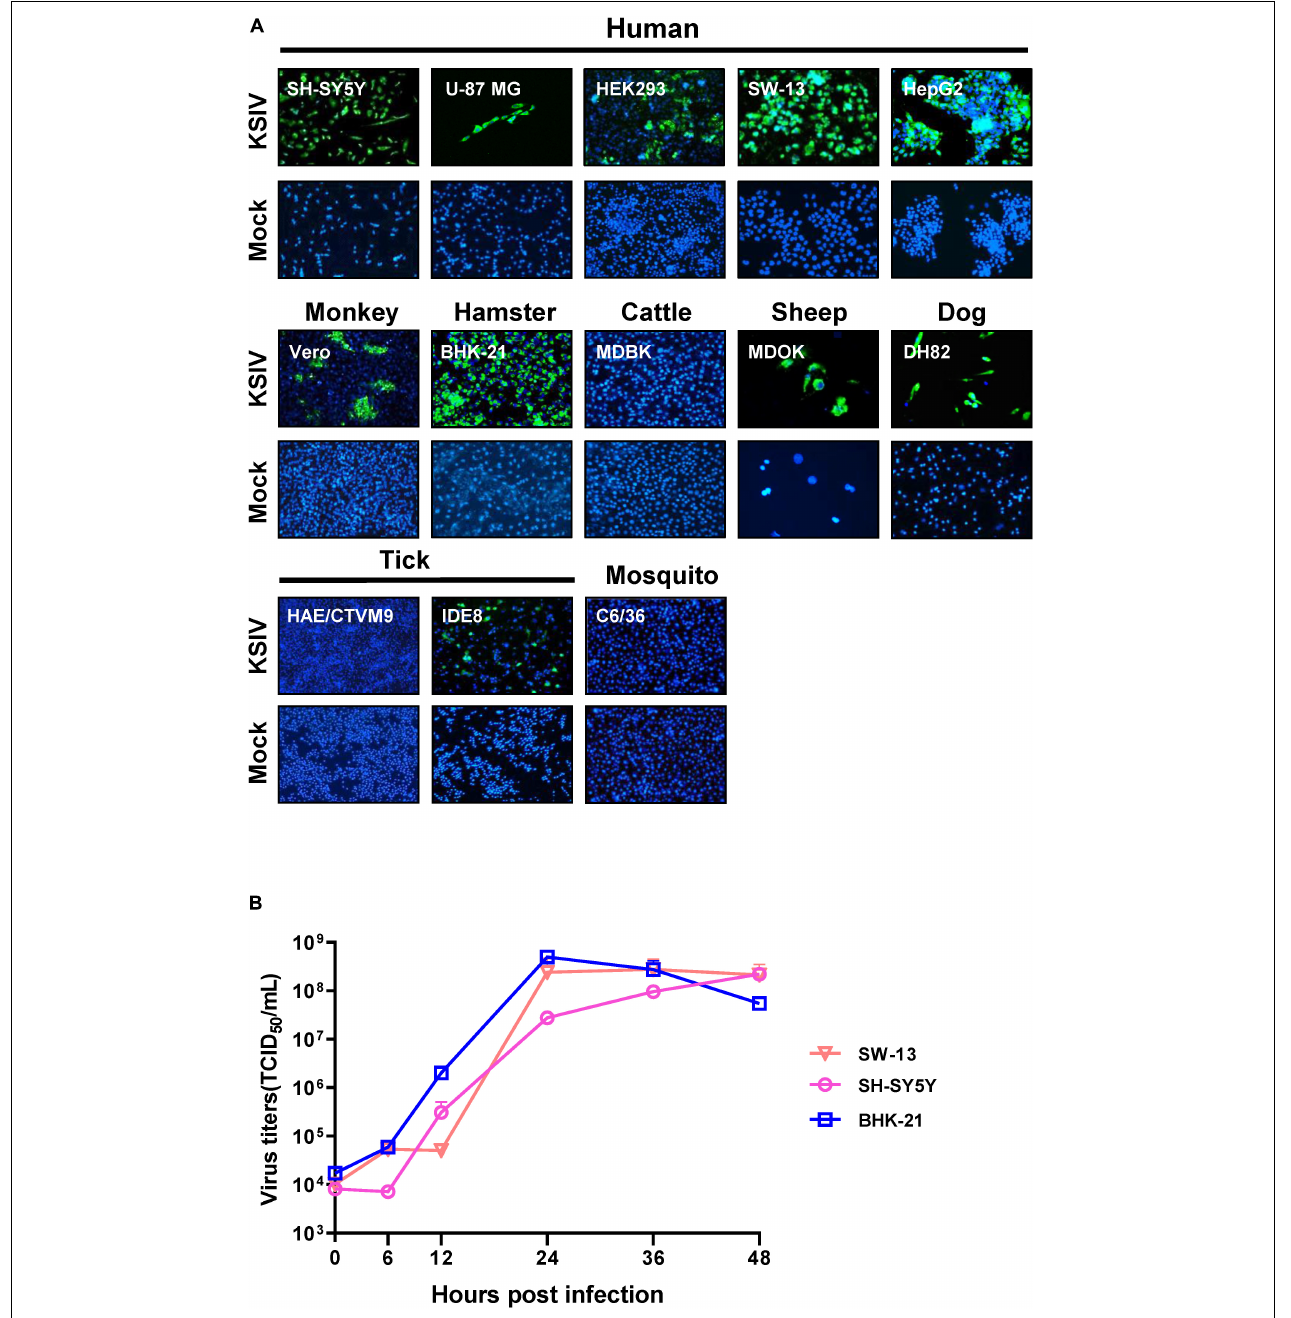
FIGURE 2 | The susceptibility of cell lines derived from different hosts to KSIV and viral one-step growth curve test. (A) Cell lines derived from humans (SH-SY5Y, U-87 MG, SW-13, HEK239 and HepG2), other mammals (Vero, BHK-21, MDBK, MDOK, and DH82), mosquito (C6/36) and ticks (HAE/CTVM9 and IDE8) were infected with KSIV at MOI of 1. The cells were cultured for 48 h and examined by immunofluorescence for KSIV E protein. KSIV infection was detected in all cell lines except MDBK, HAE/CTVM9 and C6/36. (B) The viral one-step growth curve in various cell lines. BHK-21 cells were infected with KSIV at an MOI of 5 and the supernatant for collected infection of cell lines of different species: human (SH-SY5Y, SW13) and hamster (BHK-21), virus titers were measured by end-point dilution assays.